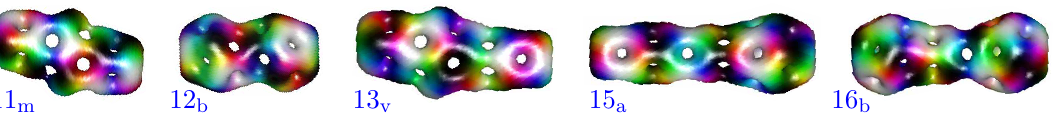
Figure 6. Chain Skyrmions made from 2- and